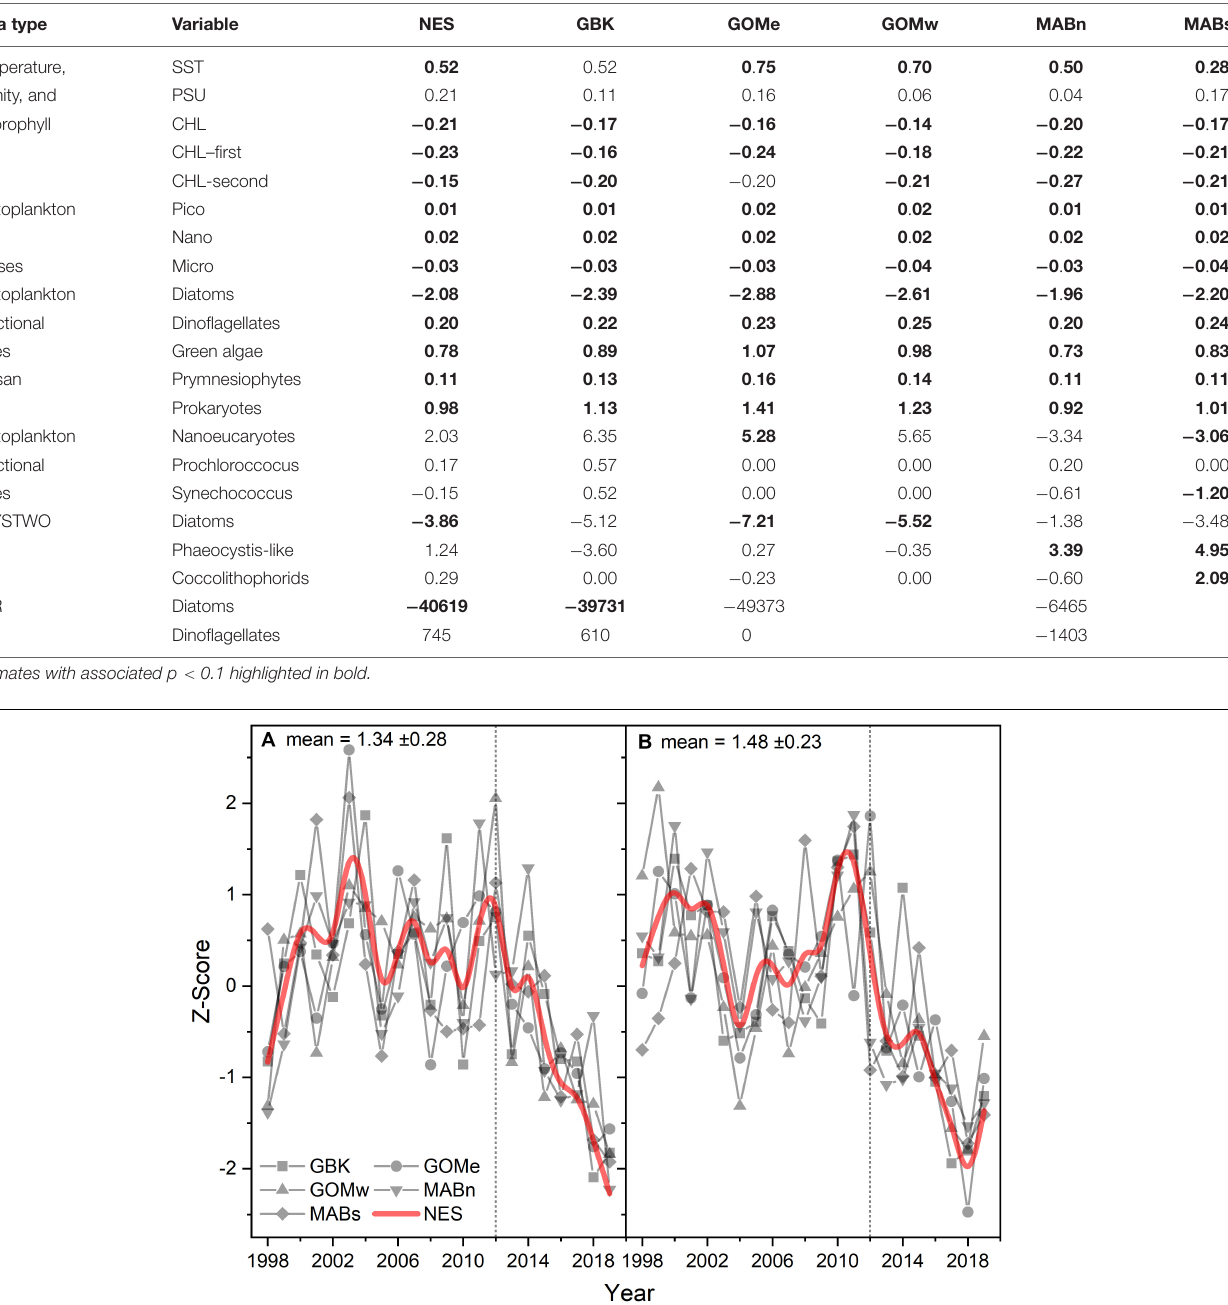
were positive trends except for diatoms, which had negative trends ( Table 1